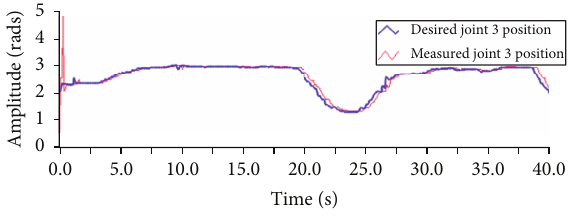
Figure 17: Desired and measured joint 3